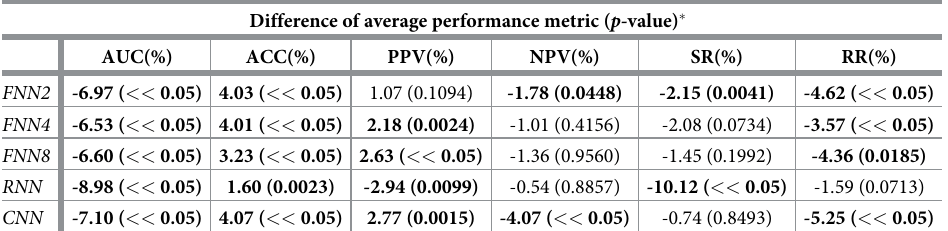
Table 8. Difference of average performance metric between NN models and the SVM